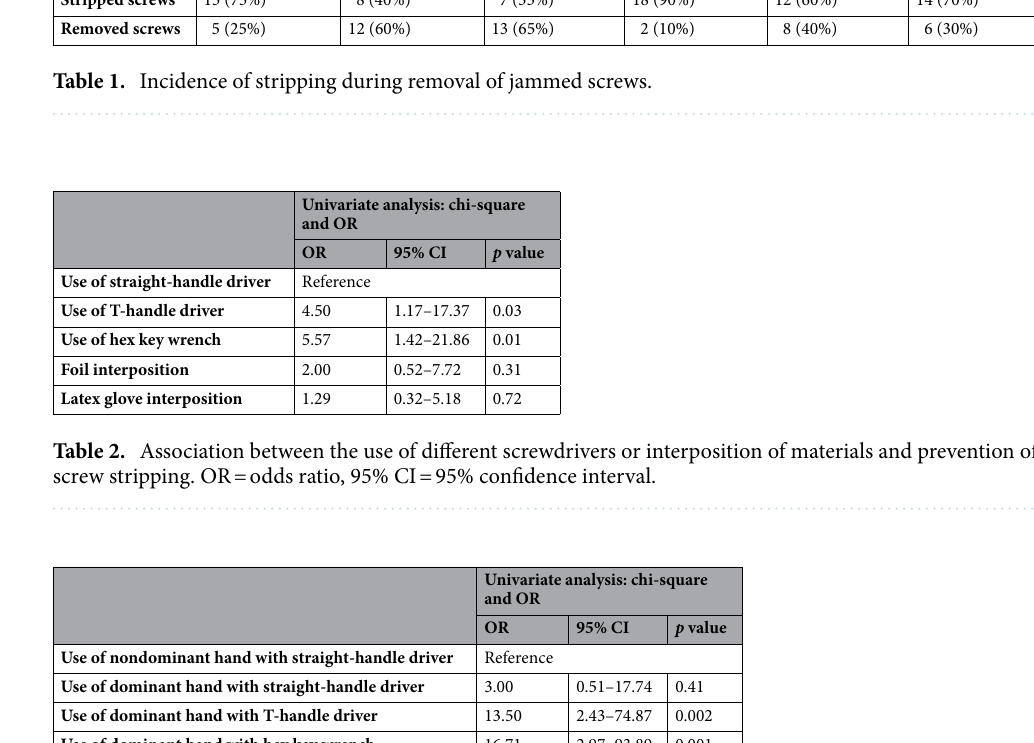
Use of nondominant hand with straight-handle